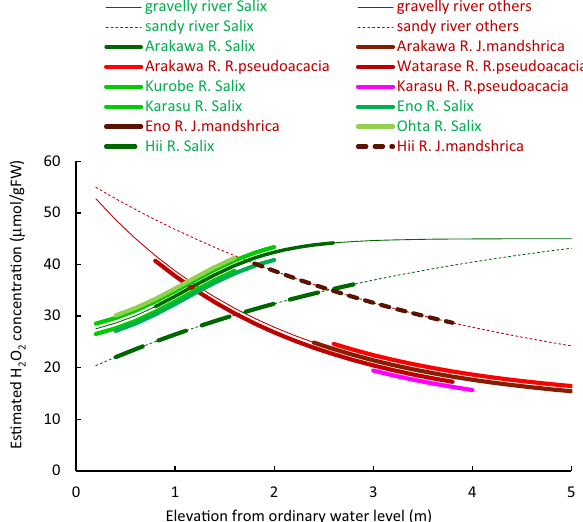
Figure 6. Estimated H 2 O 2 concentration of tree species as a function of elevation from ordinary water level, compared with observed distribution (solid lines: gravelly reaches; dashed lines: sandy reaches; thick lines: observed distribution; green lines: Salix spp.; red lines: other species; Arakawa R., Hii R., Watarase R., Eno R., Ohta R.: this study; Karas R. 17 ; Kurobe 27,66 ).